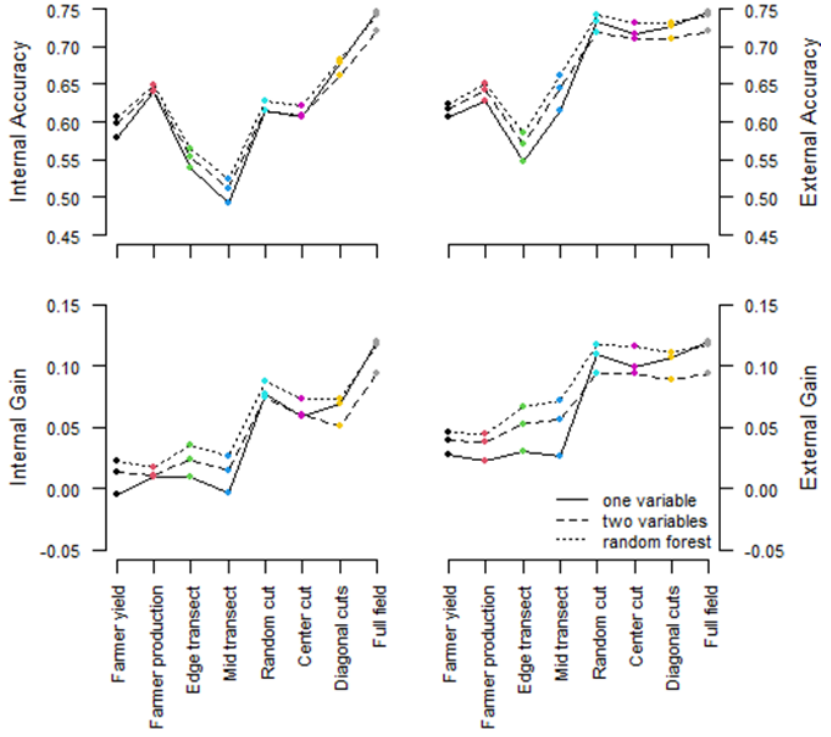
Figure A1. Internal and external accuracy for each measurement method and internal and external gain using GNDVI as the